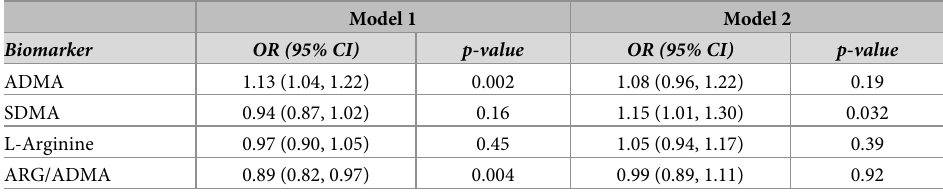
Table 2. Association of biomarkers with prevalent metabolic